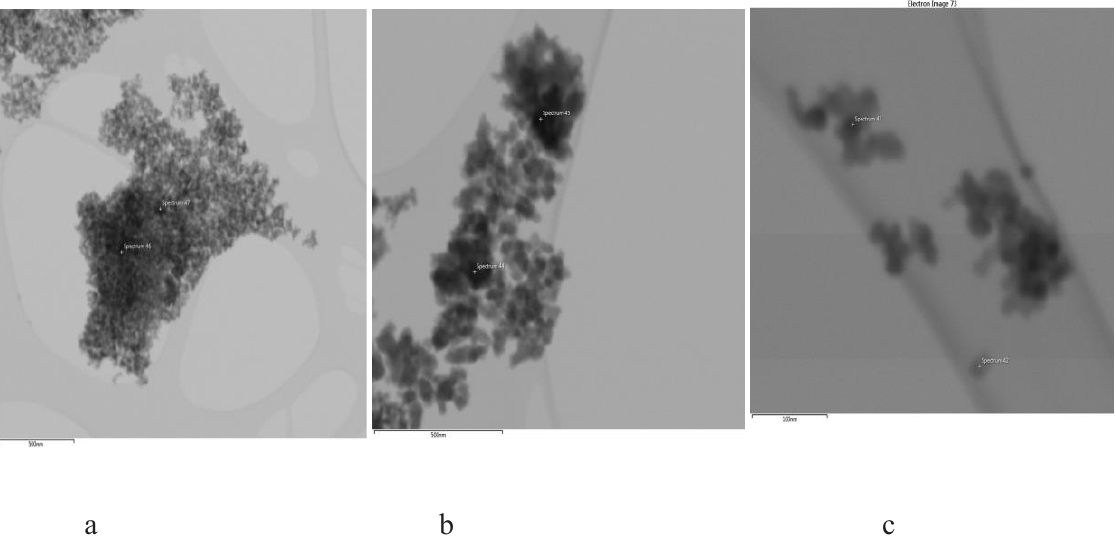
Figure 2: ТЕМ – micrographs for ZNF-Eu1, scale bar 500 nm (а), ZNF -Tb1, scale bar 500 nm (b), and ZNF-Tb5 scale bar 100 nm (c); based on them an energy dispersive X-ray microanalysis was made.